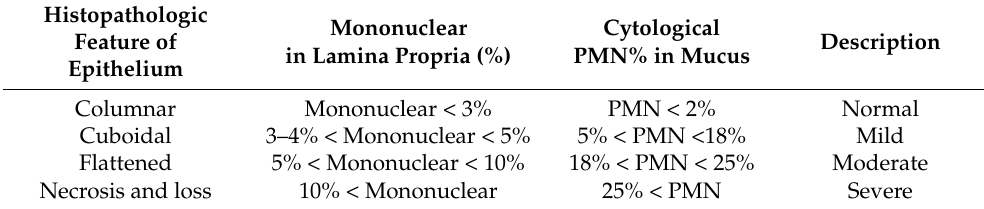
Table 1. Histopathologic and cytological scoring criteria.